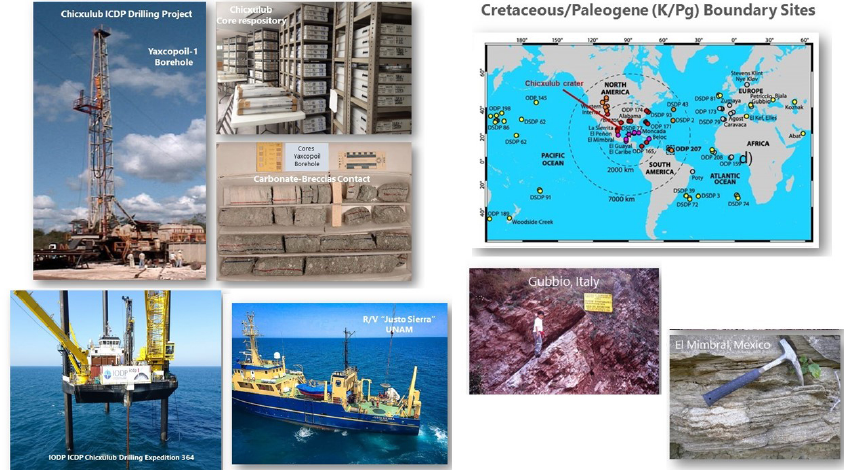
Figure 4. (a) Chicxulub drilling programmes. View of the drill rig for the Yaxcopoil-1 borehole, core samples for the impact breccias– Paleocene carbonates contact and core repository. (b) View of drilling platform for the Chicxulub IODP-ICDP Expedition 364 drilling project over the peak-ring zone. Marine geophysical surveys, view of the UNAM R/V Justo Sierra . (c) The Cretaceous–Paleogene (K–Pg) boundary is marked globally by the ejecta layer (Schulte et al., 2010). K–Pg boundary sites record a major event in life evolution. In the Gulf of Mexico–Caribbean Sea area, the boundary is characterized by high-energy sediments between the basal spherules and clay